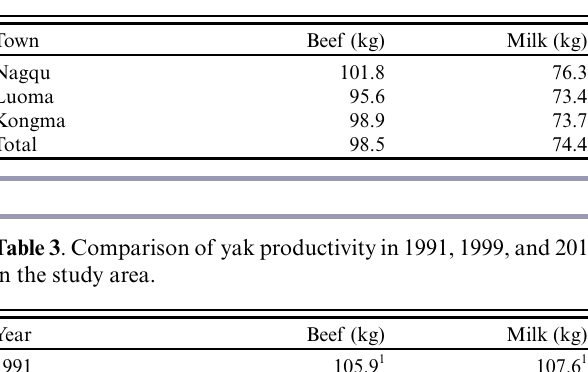
Table 2 . Average productive performances of yak in the study area (2010).